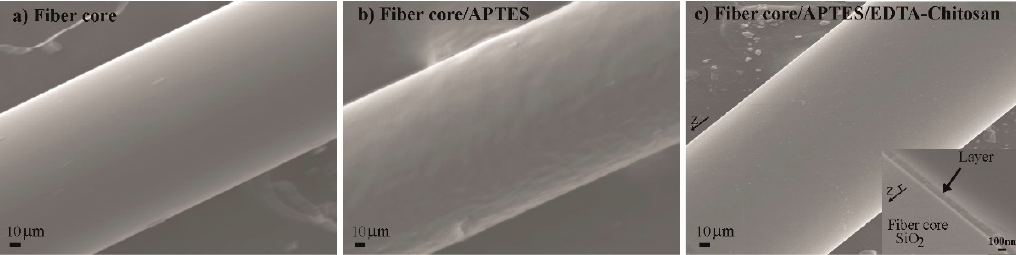
Figure 4. Scanning electron microscopy (SEM) images of ( a ) optical fiber core; ( b ) fiber core treated with APTES; ( c ) fiber core/APTES functionalized with chitosan conjugated EDTA (the inset image is a part of fiber cross-section that contains parts of immobilized layers and the fiber core).